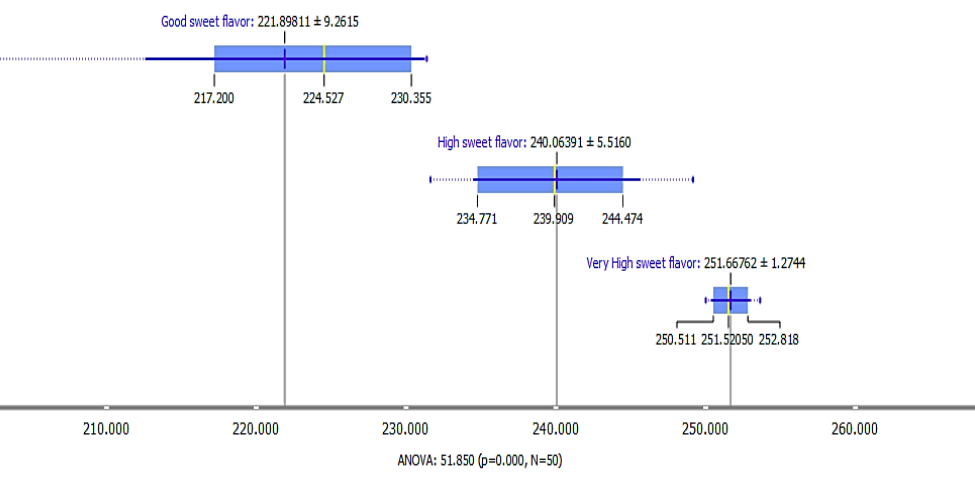
Figure 5. Classification of fruits based on red color values. (N): actual numbers of outlets; (p): probability.